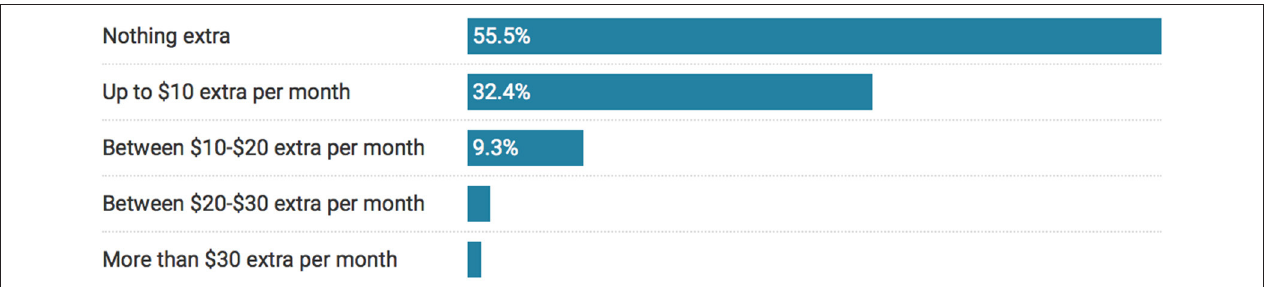
FIGURE 4 | Willingness to pay for curbside compost pickup